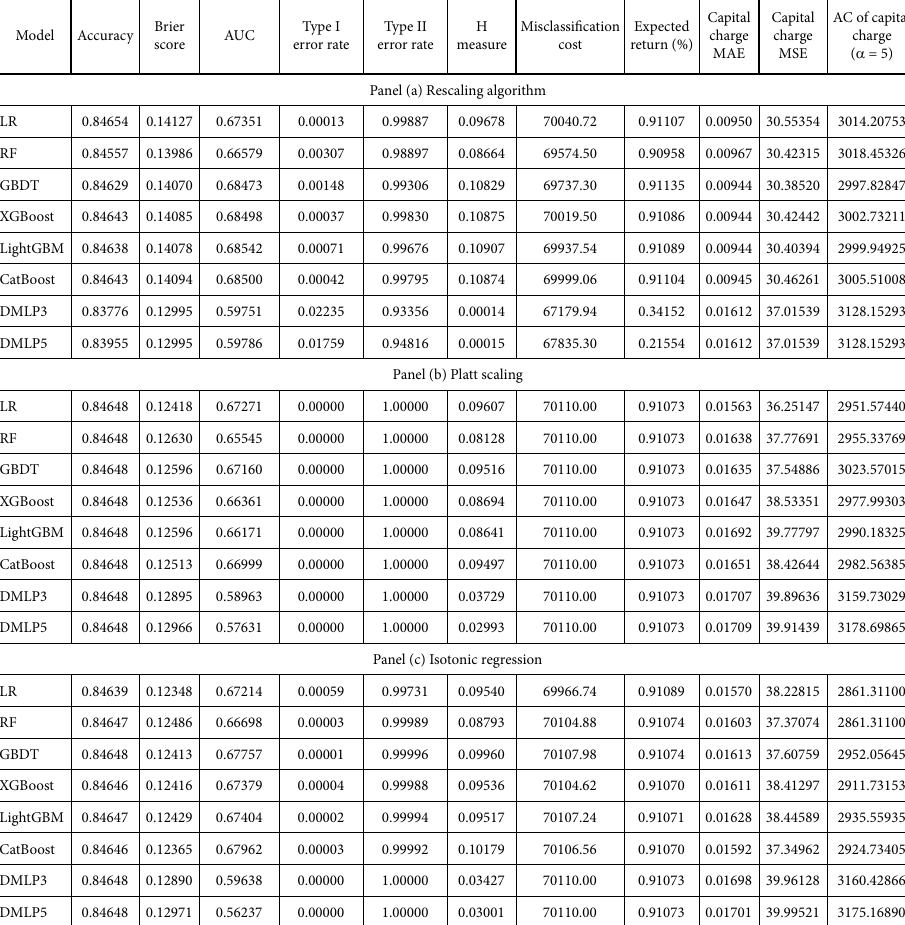
Table 8. Results of out-of-sample validation for Lending club dataset (with probability